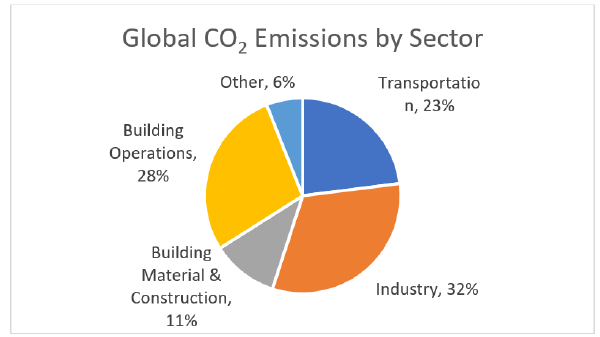
Figure 1. Global CO 2 Emissions by Sector; regenerated [2].